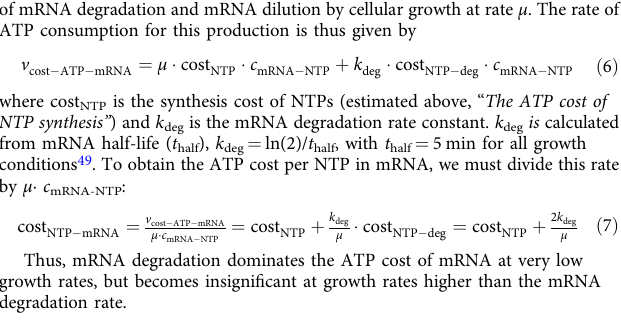
Translation initiation . During initiation, mRNA converts free ribosomes to active ribosomes: